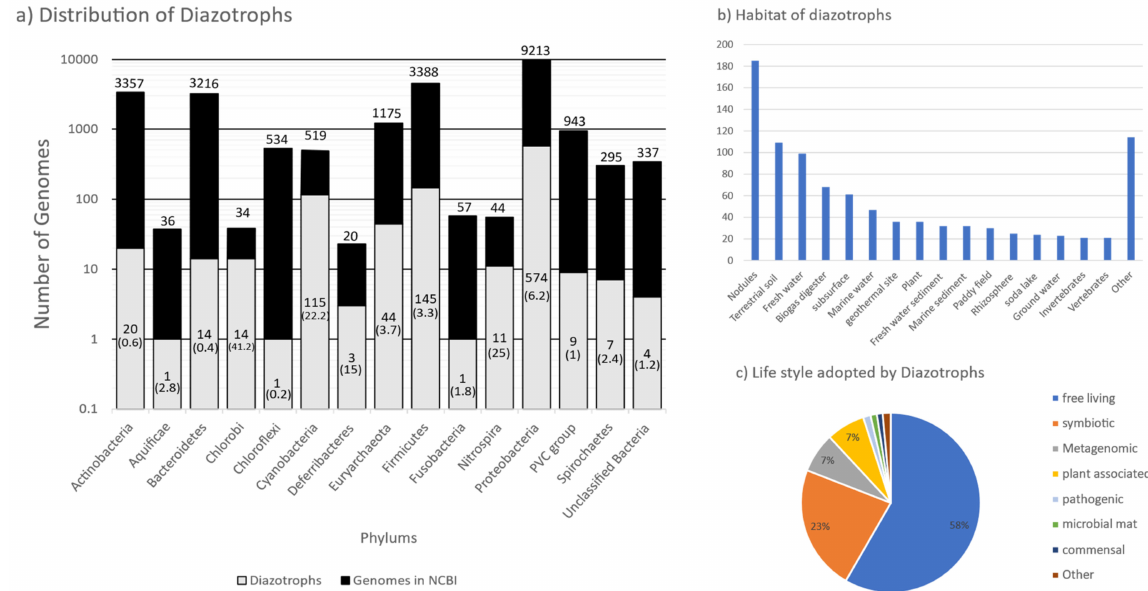
Figure 2. Distribution, habitat, and lifestyle of diazotrophs in various bacterial and Archaeal phyla. ( a ) The black bar represents the total number of genomes sequenced, and the gray bar the total number of diazotrophs in that phylum. Labels on top of black bar indicate the total number of sequenced genomes. Labels in the gray bar represent the number of genomes containing NifHDKENB in that phylum (numbers in parentheses are the percentage of sequenced genomes that have NifHDKENB). ( b ) Distribution of organisms having all six nif genes by habitat and ( c ) pie diagram showing the lifestyle adopted by various